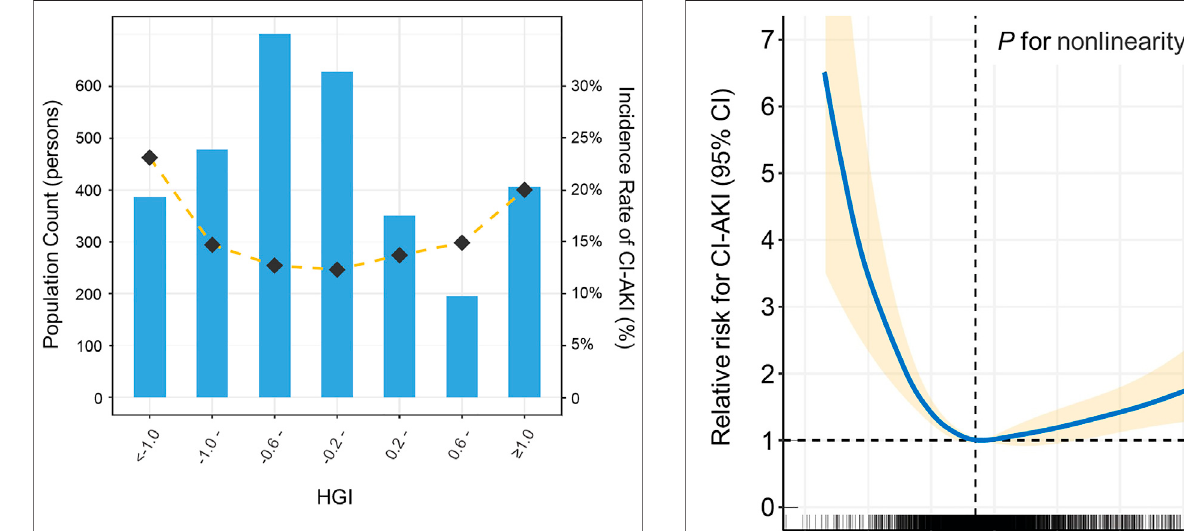
FIGURE 3 | Distribution of population and the incidence of CI-AKI according to HGI categories. Bar plots showed the distribution of the population with different levels of HGI. Gold dashed line indicated the changing trend in the incidence of CI-AKI with different HGI categories. HGI indicates hemoglobin glycation index; CI-AKI, contrast-induced acute kidney injury.